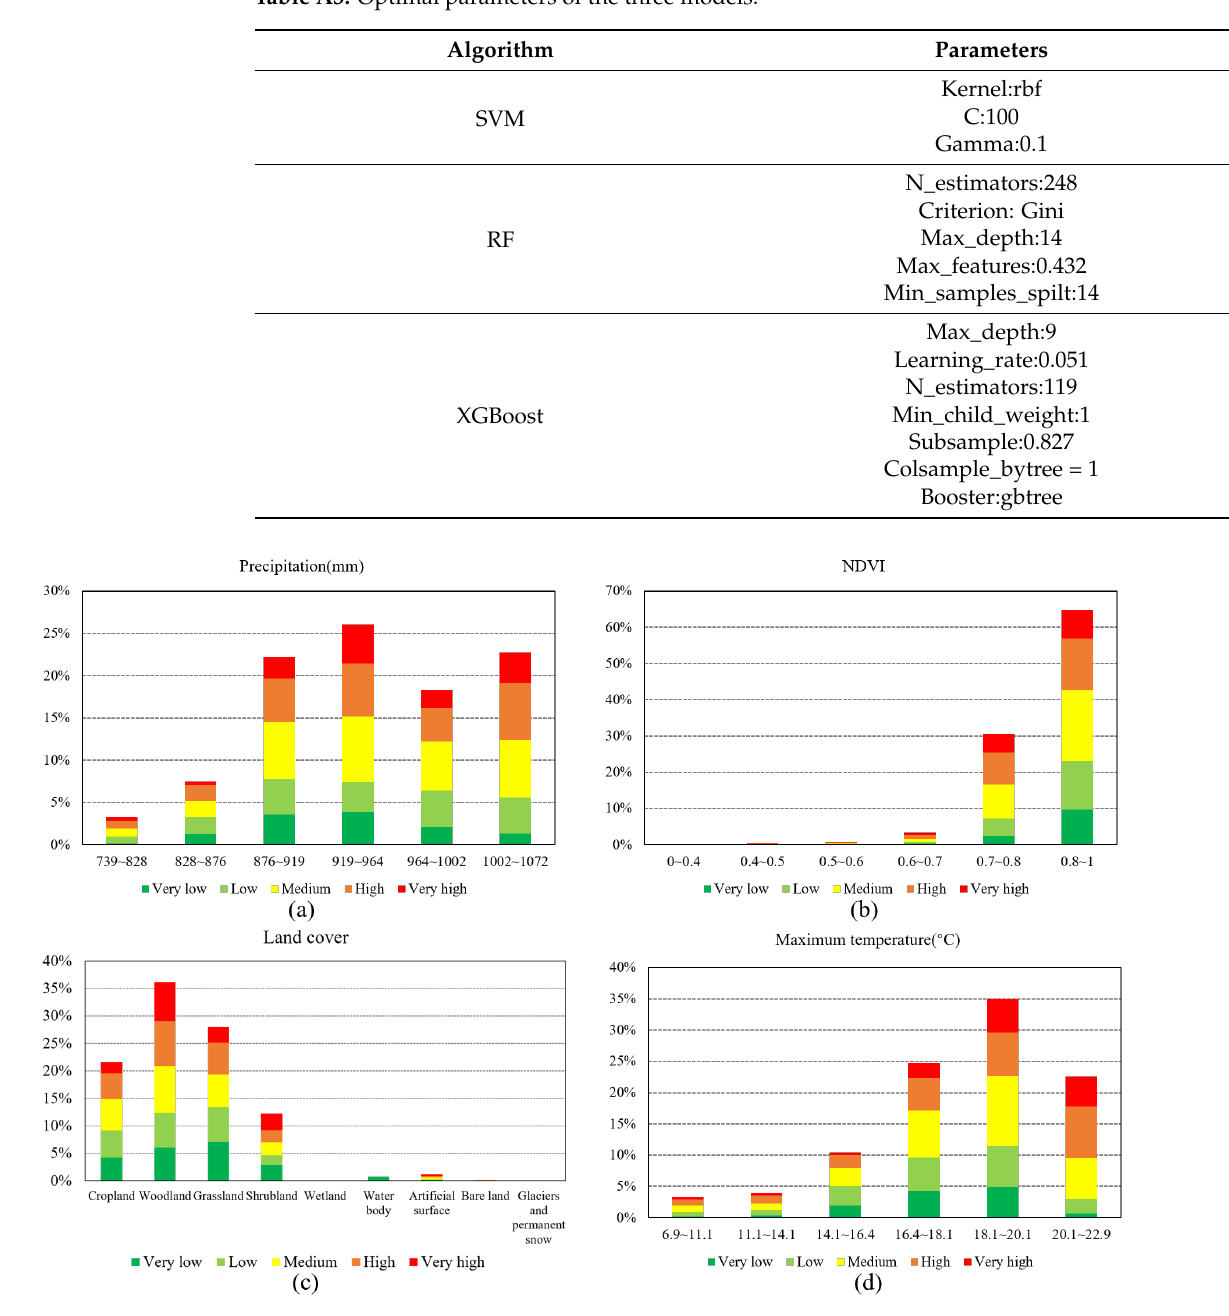
Figure A2. Main triggers of wildfires ( a ) Precipitation, ( b ) NDVI, ( c ) Land cover, ( d ) Maximum tem- perature.